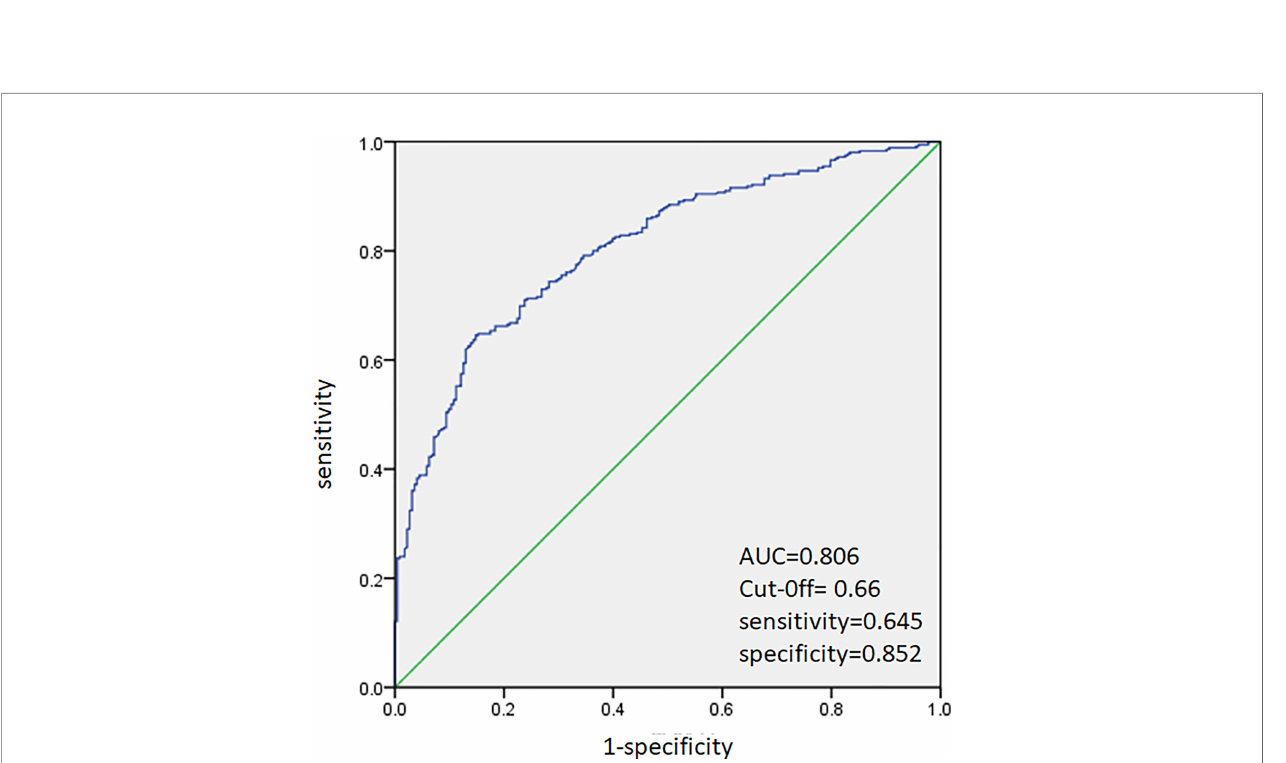
FIGURE 3 | Receiver operating characteristic curve analysis for prediction of central lymph node metastases using the multivariate model in non-HT patients.